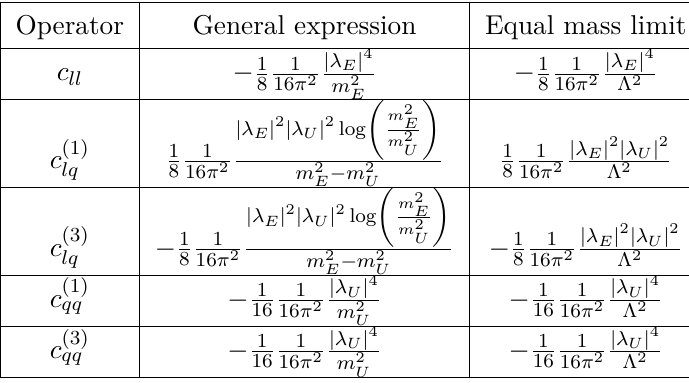
Table 12. Matching for the simple “EU” model in the limit of λ SM → 0 .